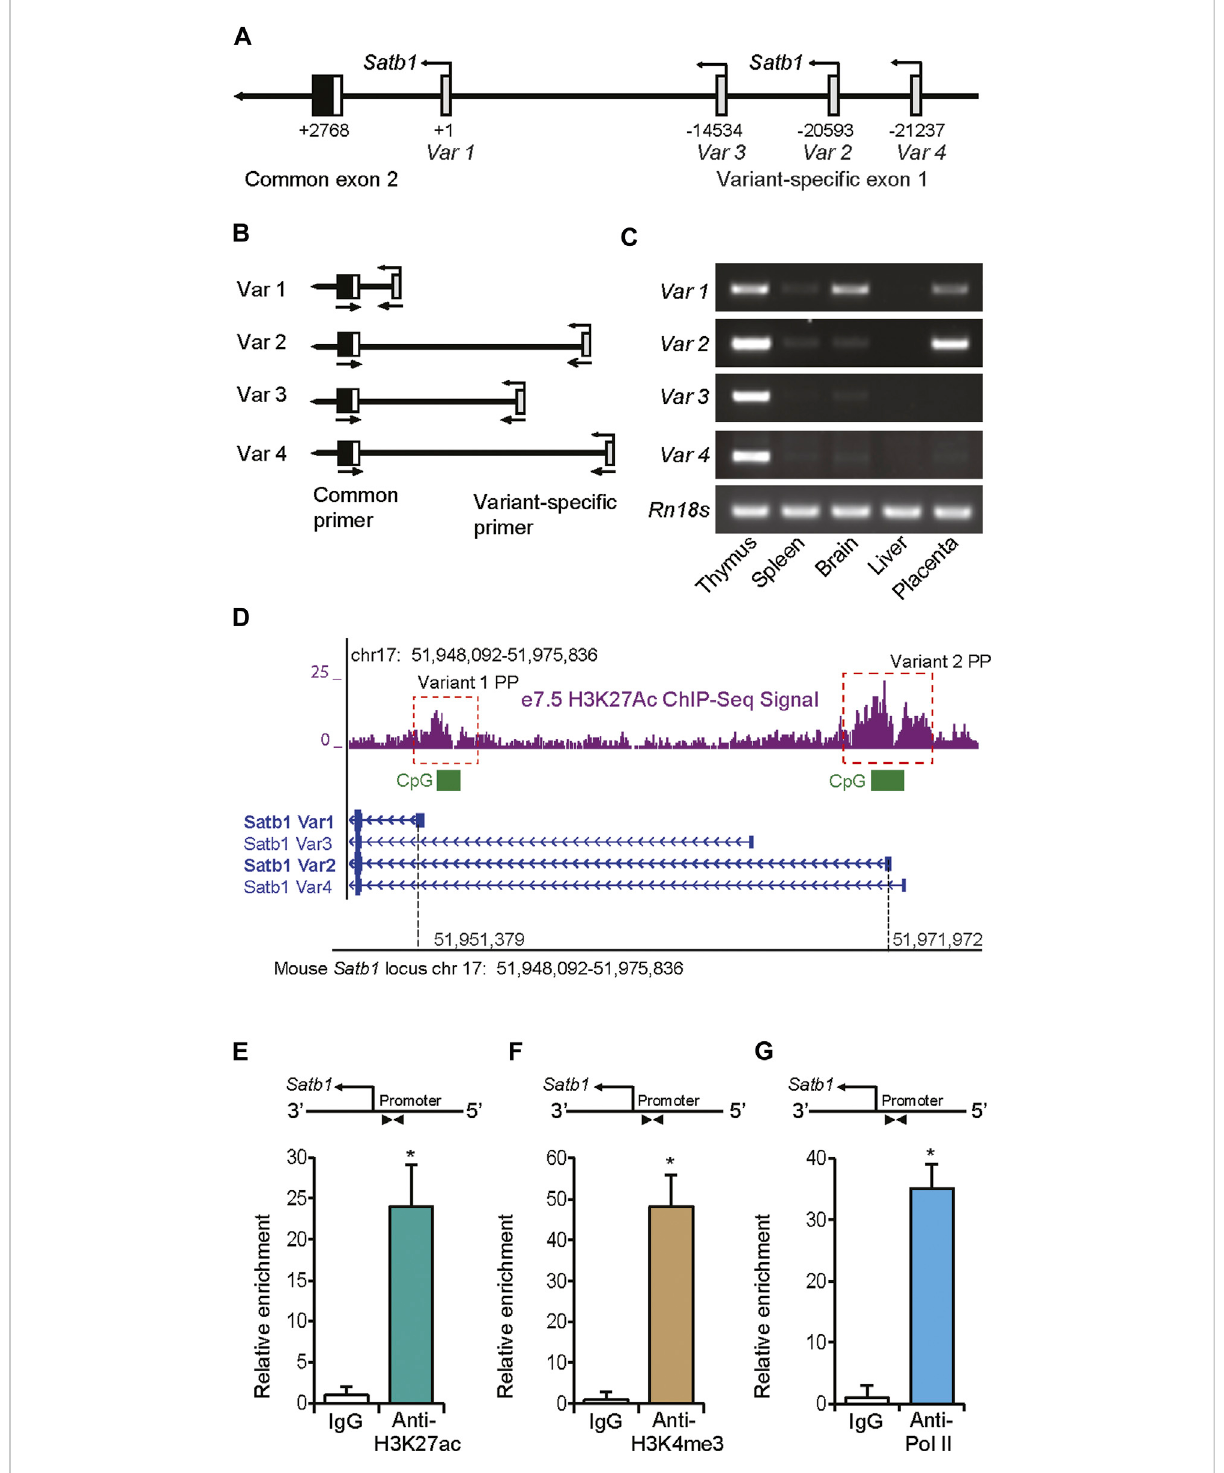
FIGURE 2 Detectionoftrophoblast-speci fi c Satb1 promoters. (A) Schematic presentation ofthemouse Satb1 genelocus showingfour transcriptvariants, each transcribed from a variant-speci fi c alternative exon 1. Nucleotide positions are indicated with respect to the start site (TSS) of variant 1. (B) Strategy of PCR-based detection of different transcript variants. (C) Satb1 transcript variants and alternative transcription start sites were detected in mouse embryonic day 7.5 (e7.5) ectoplacental cone (EPC) by RT-PCR analyses. Satb1 transcript variants in mouse thymus, spleen, brain, and liver were detected as controls for comparison. (D) ChIP-seq data on e7.5 EPCs demonstrated that both variant 1 and 2 proximal promoters